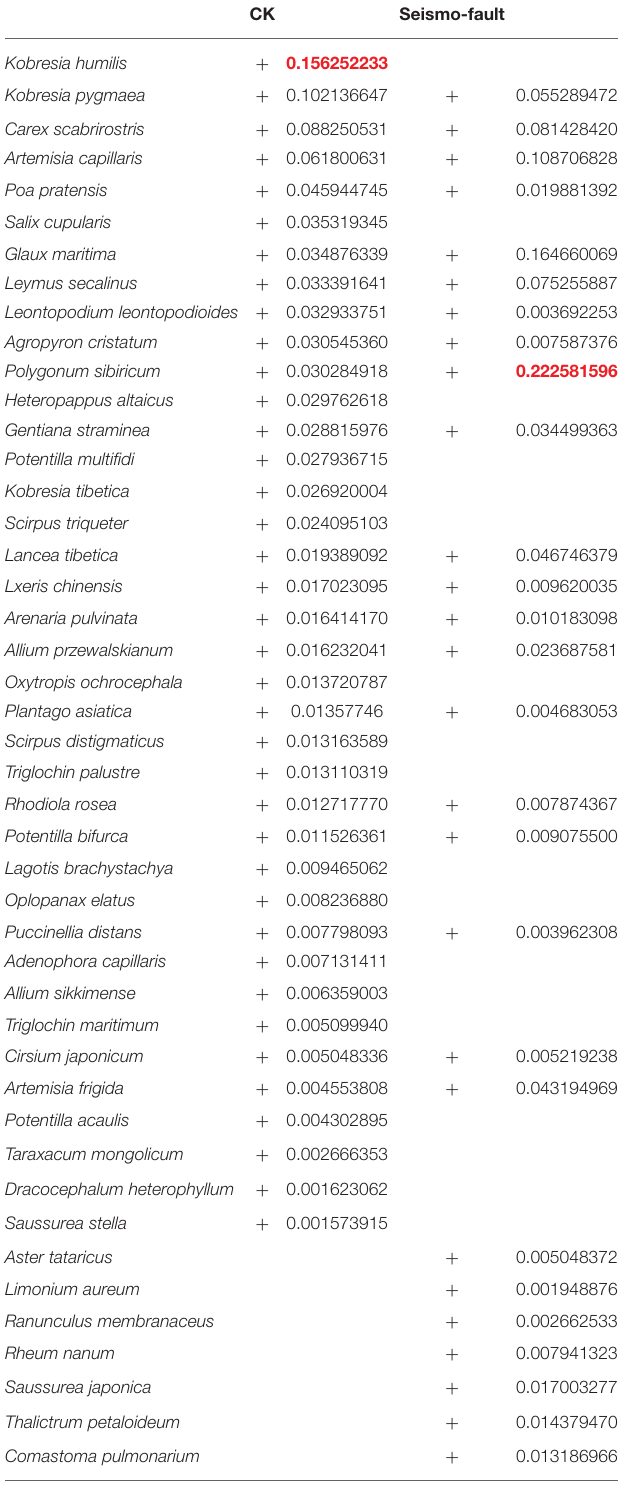
TABLE 2 | Species importance values under the influence of earthquake